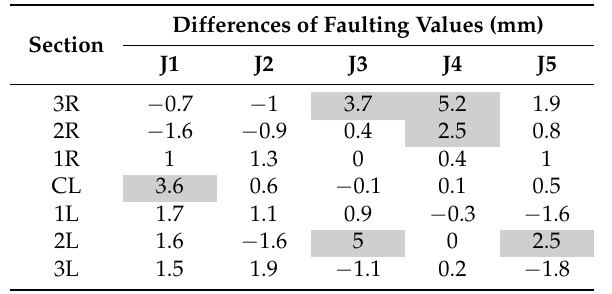
Table 7. Differences of faulting values obtained using planar model or 300 mm long strips. Faulting values exceeding 2 mm are highlighted in grey. Differences of Faulting Values Section